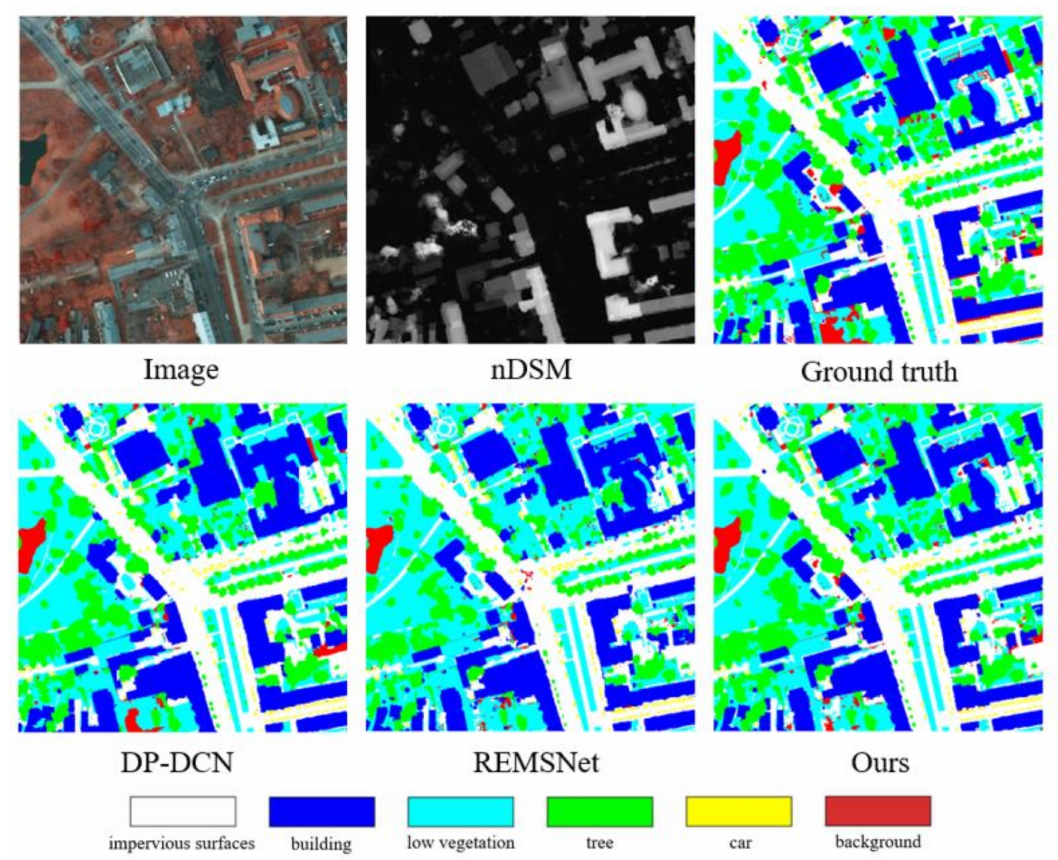
Figure 8. The results of MMAFNet and other comparative methods on the Potsdam